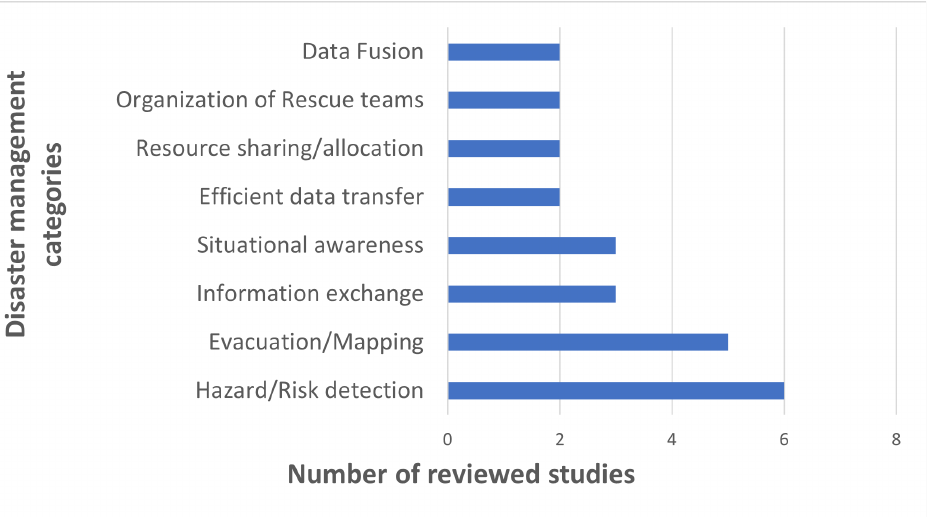
Figure 8. Disaster Management Categories Addressed by the Reviewed Studies.